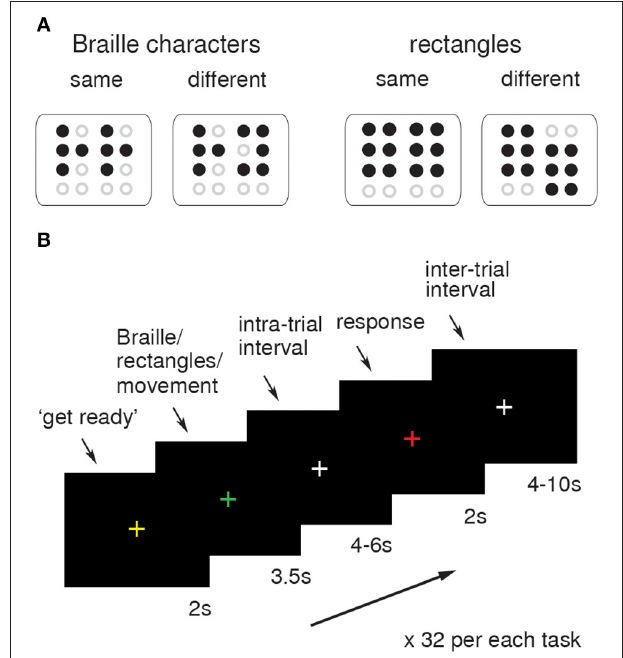
FIGURE 1 | fMRI procedure. Examples of same-different Braille characters and rectangles used as tactile stimuli during functional run (A) . The schema of the visual presentation used as a task-cue for subjects. The change of the fixation cross (“ + ”) was coupled with tactile (Braille/rectangles) stimuli presentation and submission of answers (B)